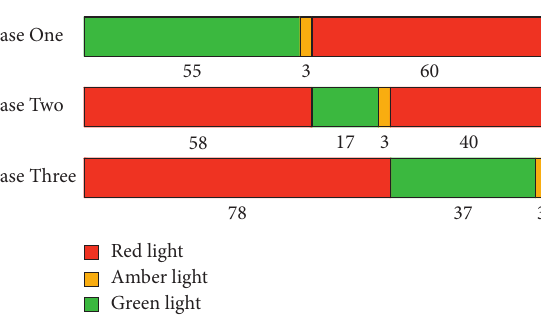
Figure 6: Timing scheme of intersection. Table 3: Traffic volume and performance indicators at the intersection.